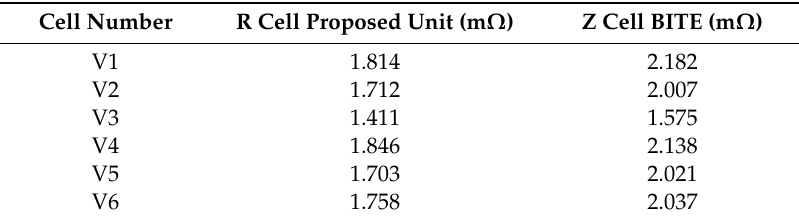
Table 1. Results of the proposed unit vs. MEGGER BITE.